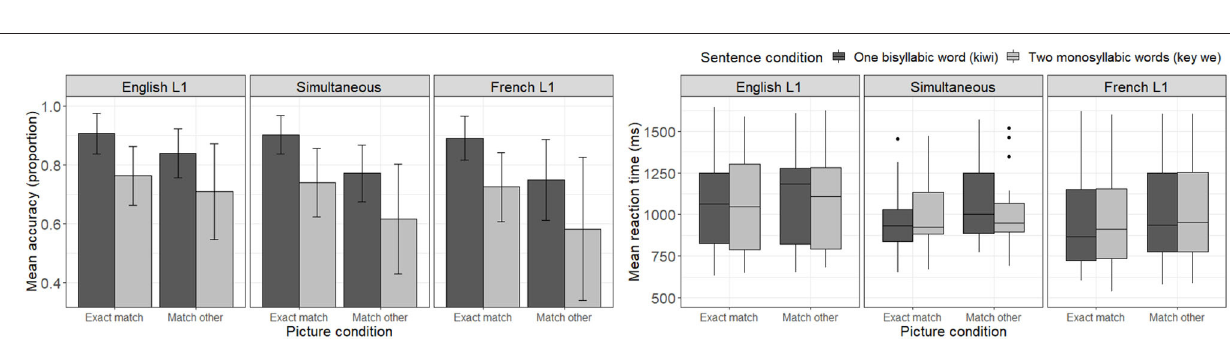
FIGURE 2 | Mean accuracy (left) and reaction time (ms) to correct response (right) to French trials as a function of sentence and picture conditions, as well as participants’ native language.